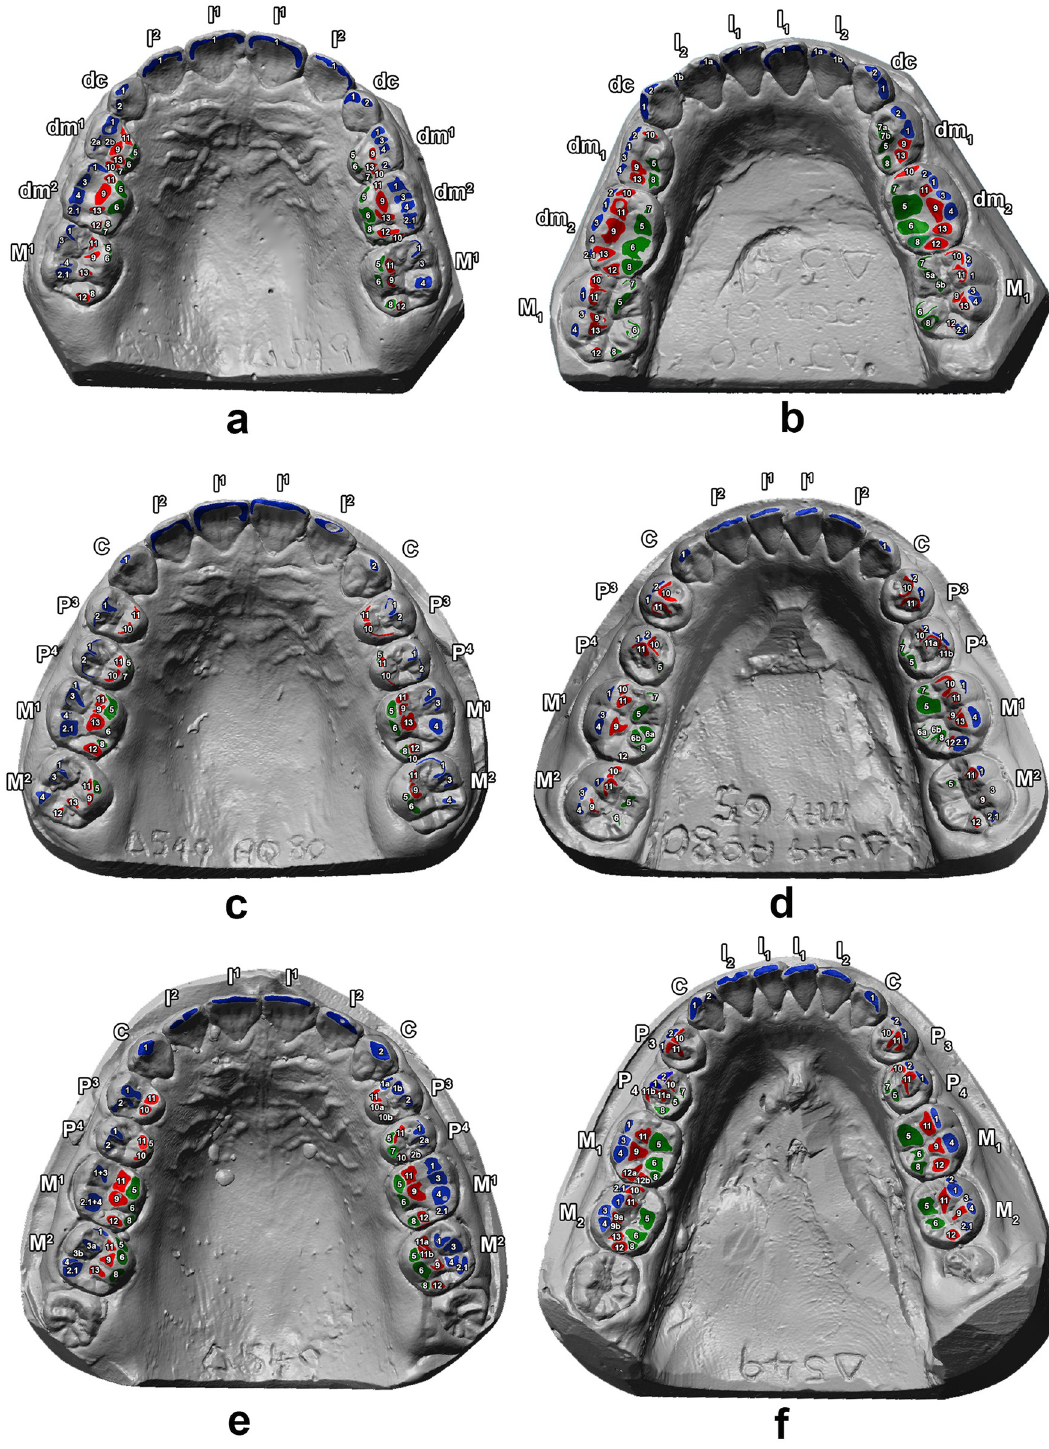
Fig 3. Three-dimensional digital models of upper and lower arches showing the macrowear patterns. Wear contacts have been labelled following the numbering system created by Maier & Schneck [30] and grouped by chewing cycle phases [31, 32]: Buccal phase I (areas 1, 1.1, 2, 2.1, 3 and 4; coloured in blue), Lingual phase I (areas 5, 5.1, 6, 6.1, 7 and 8; coloured in green) and Phase II (areas 10, 11, 12 and 13; coloured in red). CA1 upper ( a ) and lower ( b ) arches, age E 8.07 years; CA4 upper ( c ) and lower ( d ) arches, age E 12.44 years; CA9 upper ( e ) and lower ( f ) arches, age E 17.44 years.